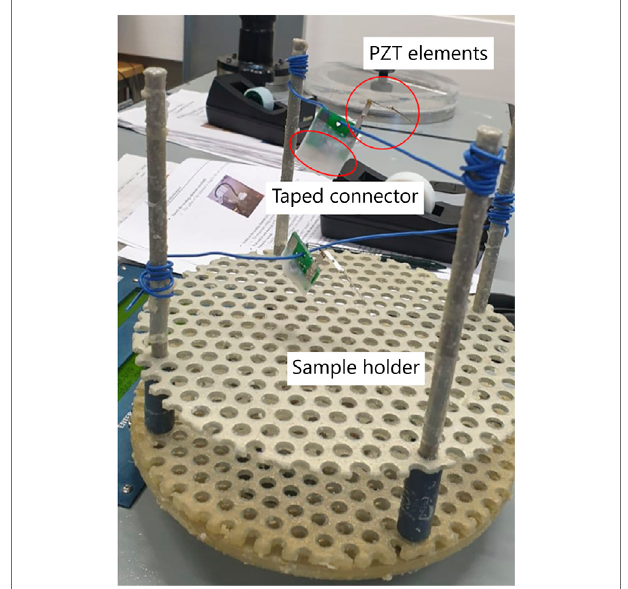
FIGURE 1 | Attachment of the sensor in the sample holder of parylene coating equipment and keeping them in a standing condition with a piece of wire for uniform coating of the polymer in all sides of the sensor during the